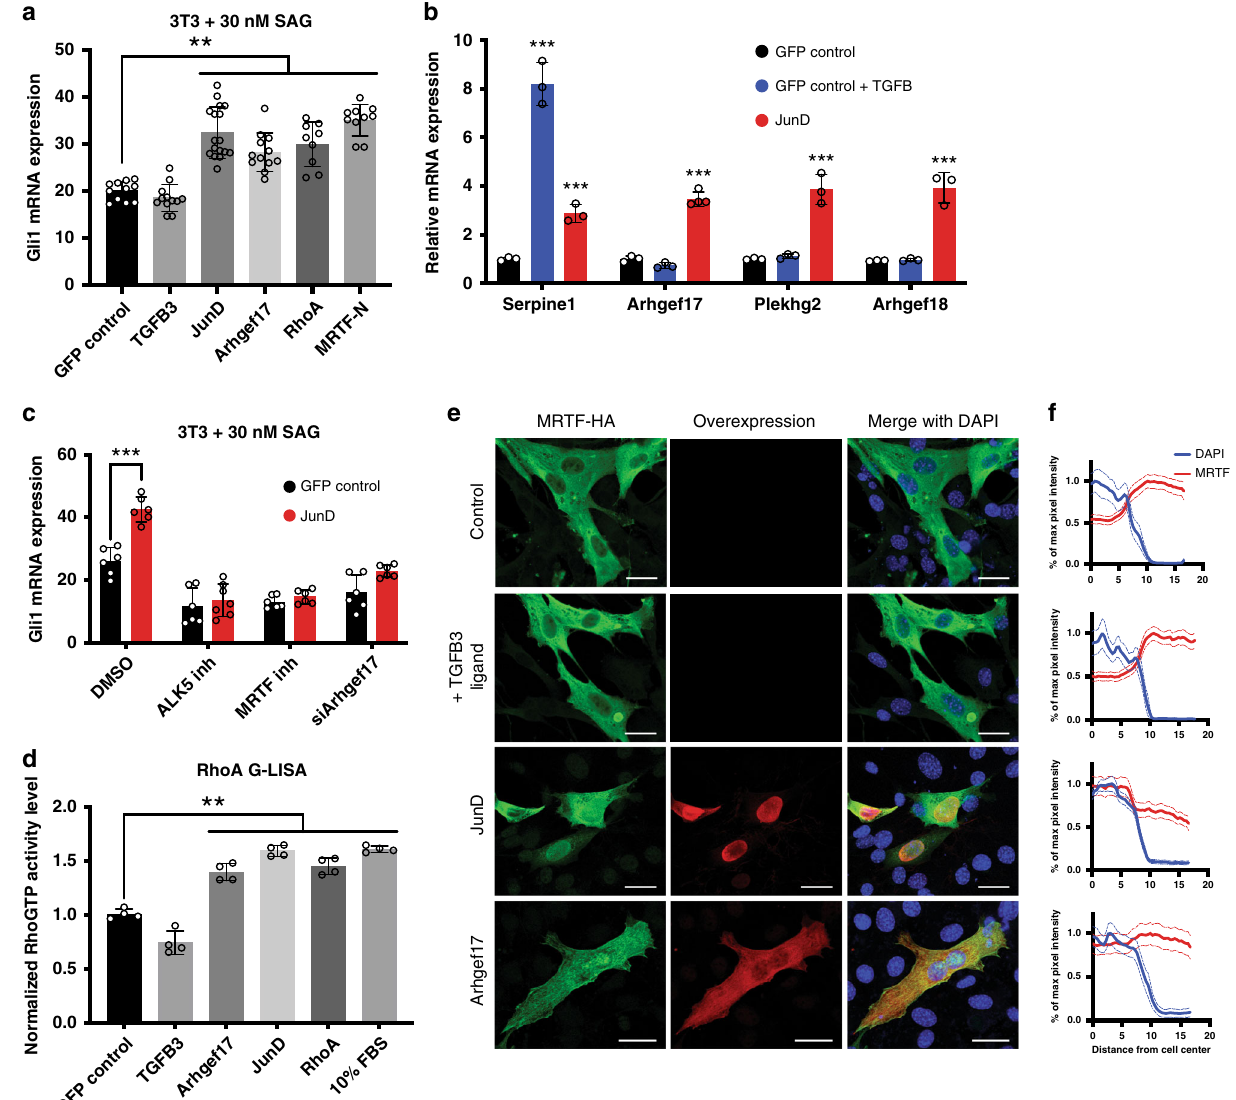
Fig. 5 JunD/AP-1, but not TGFß, is suf fi cient to drive nMRTF. a Enhancement of Hh signaling in NIH-3T3 cells measured by Gli1 qRT-PCR transiently transfected with overexpression constructs for 48 h and treated with 30 μ M Smoothened agonist (SAG) for 24 h. ** p < 0.01. b qRT-PCR of various target genes in 3T3s transiently transfected with GFP control vectorwith or without 5 ng/ml TGFß ligand supplementation, or JunD overexpression construct. *** p < 0.001. c Gli1 qRT-PCR in 3T3 cells transiently transfected with GFP control vector or JunD and treated with 30 μ M Smoothened agonist (SAG) for 24 h. *** p < 0.0001. d RhoA activation quanti fi ed by G-LISA assay in 3T3 cells transiently transfected with GFP control or overexpression constructs for 48 h. ** p < 0.01. Open circles on all bar graphs represent independent biological replicates. All error bars represent mean + / − SD. P -values calculated using unpaired, two-tailed Student ’ s t -test. e IF images of 3T3 cells transfected with HA-tagged MRTF construct with or without 5 ng/ml recombinant TGFß ligand supplementation, Arhgef17 or JunD overexpression construct. Scale bar = 25 μ m. f Quanti fi cation of MRTF intensity across cell radius in ( e ), measured as µ m distance from cell center. Nuclear boundaries represented as DAPI intensity. Mean intensities of n > 50 cells shown as solid lines, with SEM as dotted (Supplementary Fig. 5e). Whether Jun and Smad proteins are necessary to gauge its potential as a therapeutic for BCC. By actually forming heterocomplexes on AP-1 binding sites, or discovering the surface markers as a predictor of the appro- binding distinct nearby cis elements is a question that is still priateness of combination therapies, we have advanced the pos- under debate and merits further study 56 – 58 . sibility to target both the canonical and non-canonical drivers of Finally and importantly, we have shown that nMRTF BCC cells resistance at once, and therefore maintain tumor therapeutic exist as a distinct cell state, which can be effectively targeted with response. small-molecule MRTF and AP-1 inhibitors, using LYPD3, TACSTD2, and LY6D as prognostic markers. We have also shown that in heterogenous tumors, combining AP-1 and SMO inhibitors can be a useful way to increase ef fi cacy and widen the therapeutic window. Further pre-clinical in vivo studies are